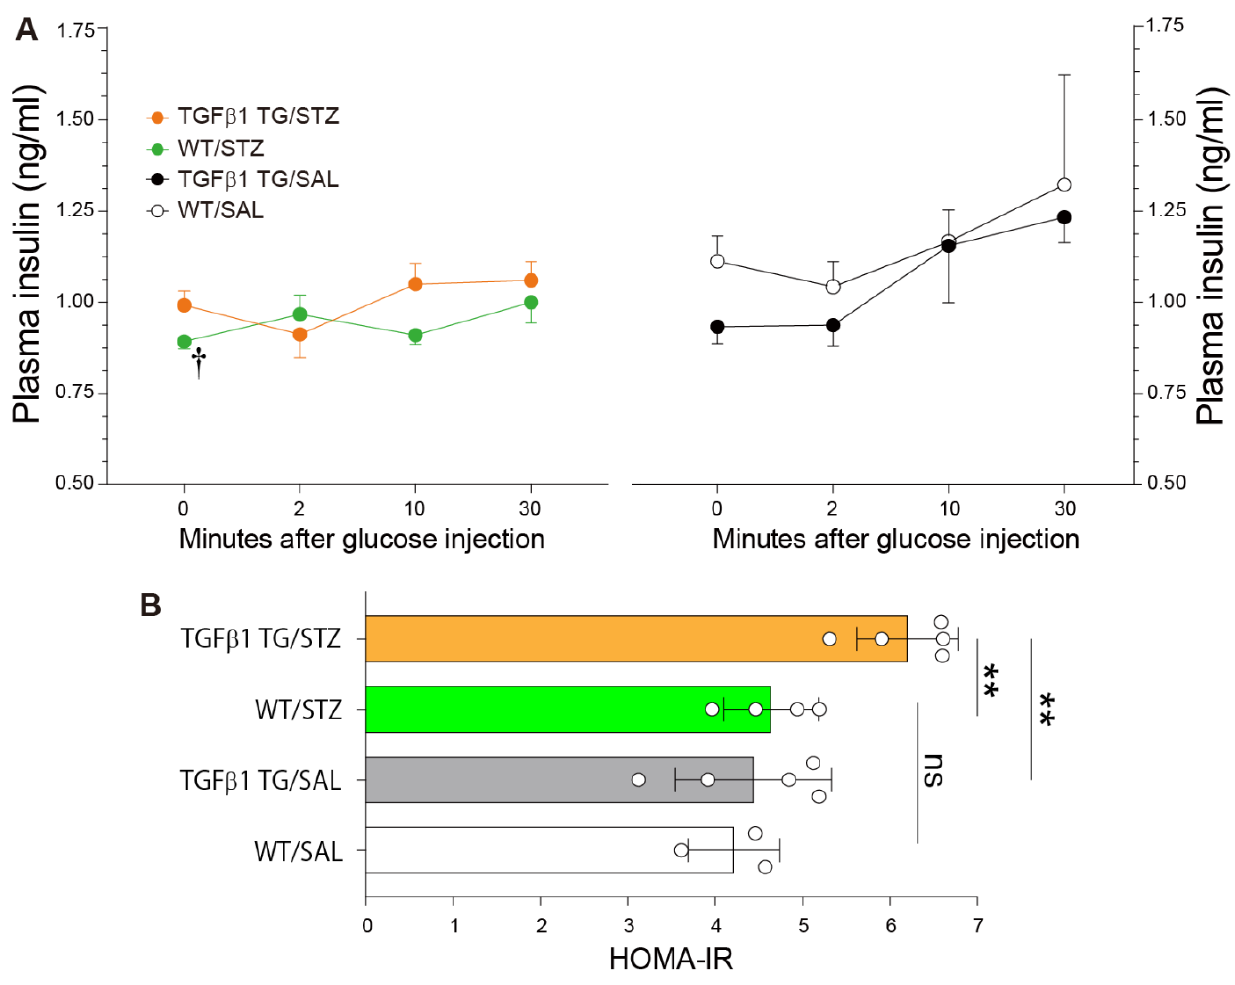
Figure 3. Reduced plasma insulin levels after glucose injection and insulin resistance in diabetic TGF β 1 TG mice. ( A ) The glucose-stimulated insulin secretion test was performed after 16 h of fasting by the intraperitoneal injection of glucose. Insulin was measured using blood samples taken after 0, 2, 10, and 30 min of glucose injection. ( B ) Homeostasis model assessment for insulin resistance (HOMA-IR) was determined before glucose administration, as described in the Materials and Methods. Number of mice: n = 3 in WT/SAL, n = 5 in TGF β 1 TG/SAL, n = 4 in WT/STZ, n = 5 in TGF β 1 TG/STZ. Data are the mean ± S.D. Statistical analysis by Kruskal – Wallis ANOVA with Dunn’s test. † p < 0.05 vs. WT/SAL; ** p < 0.01; ns, not significant.